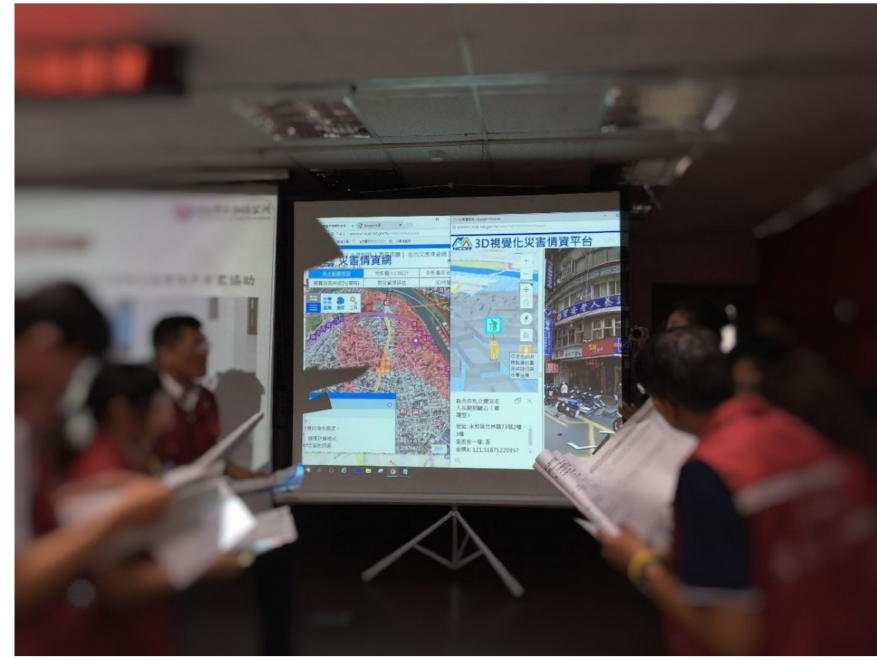
Figure 20. The street view of a care center for the elderly. (Photographed by Yong-Jun